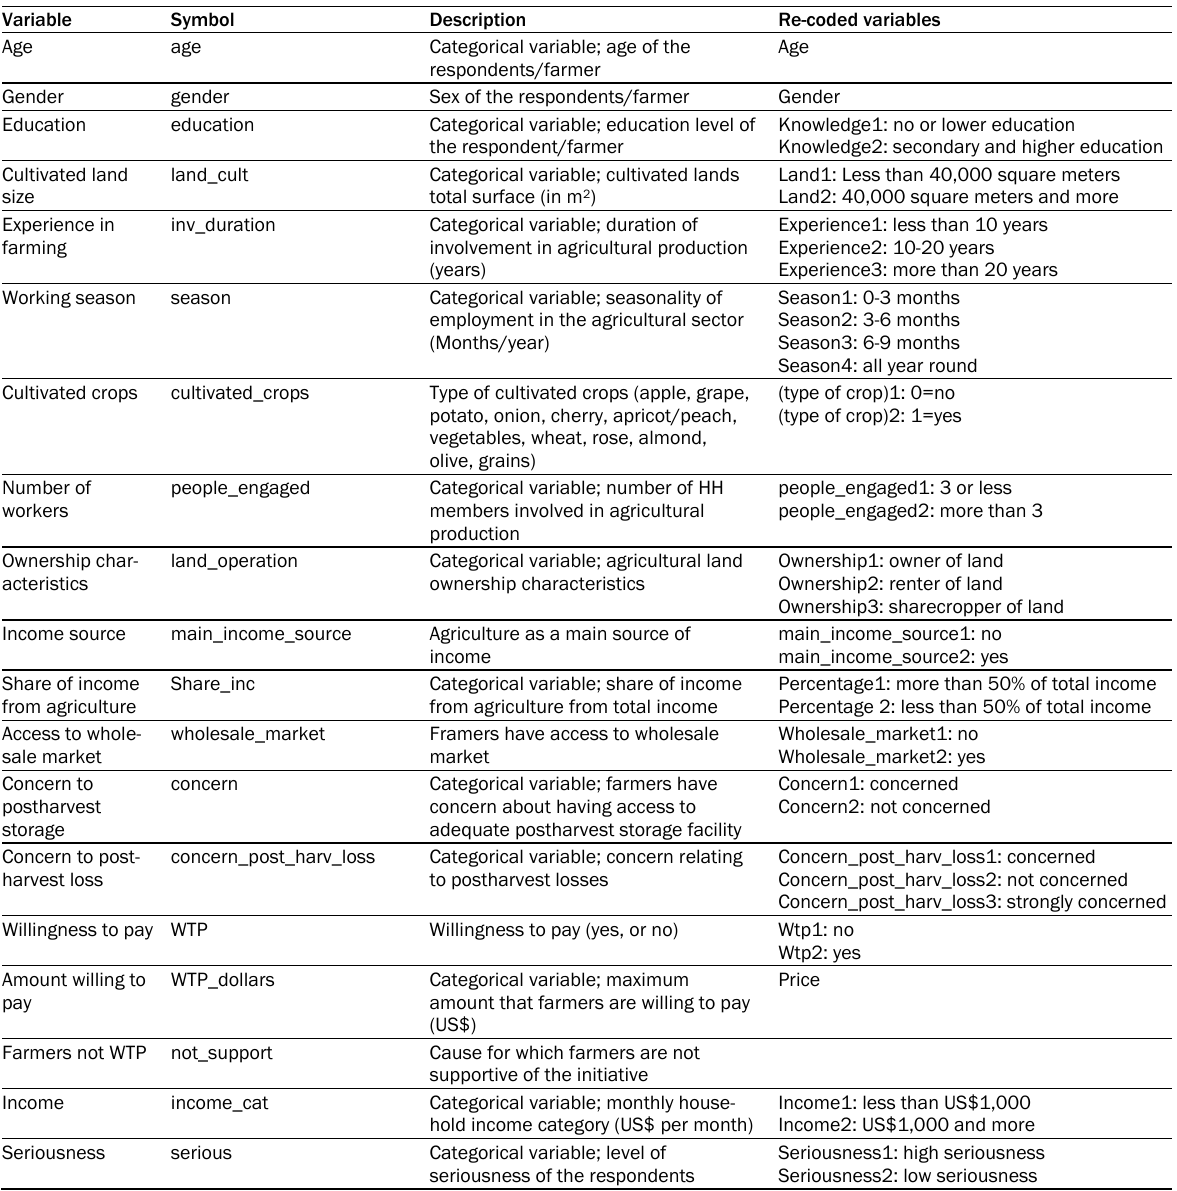
Table 1. Summarized List of Selected Variables Considered in the Data